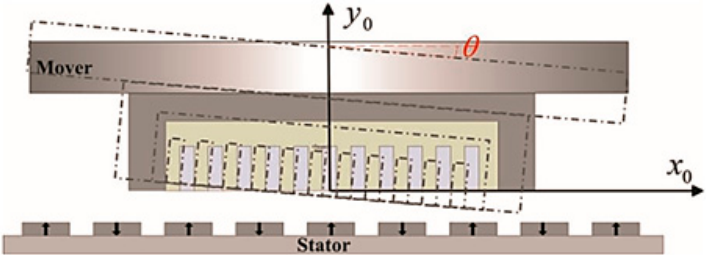
Figure 30. The influence of pitch vibration on the air gap [131] . Reprinted with permission from ref. [131]. Copyright 2015 Elsevier